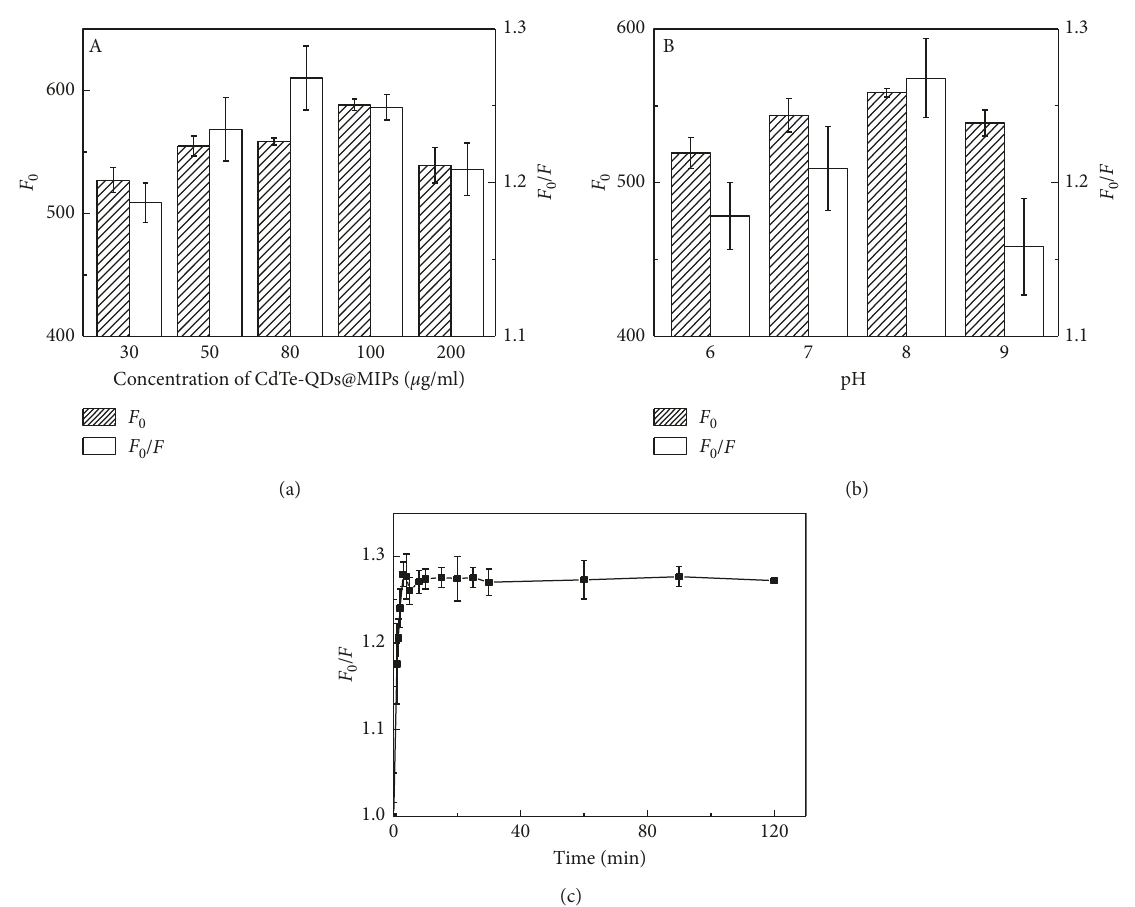
Figure 6: Effect of the concentration of CdTe-QDs@MIPs (a), pH (b), and incubation time (c) on the response of CdTe-QDs@MIPs to FA (concentration of FA at 10 μ g/l).